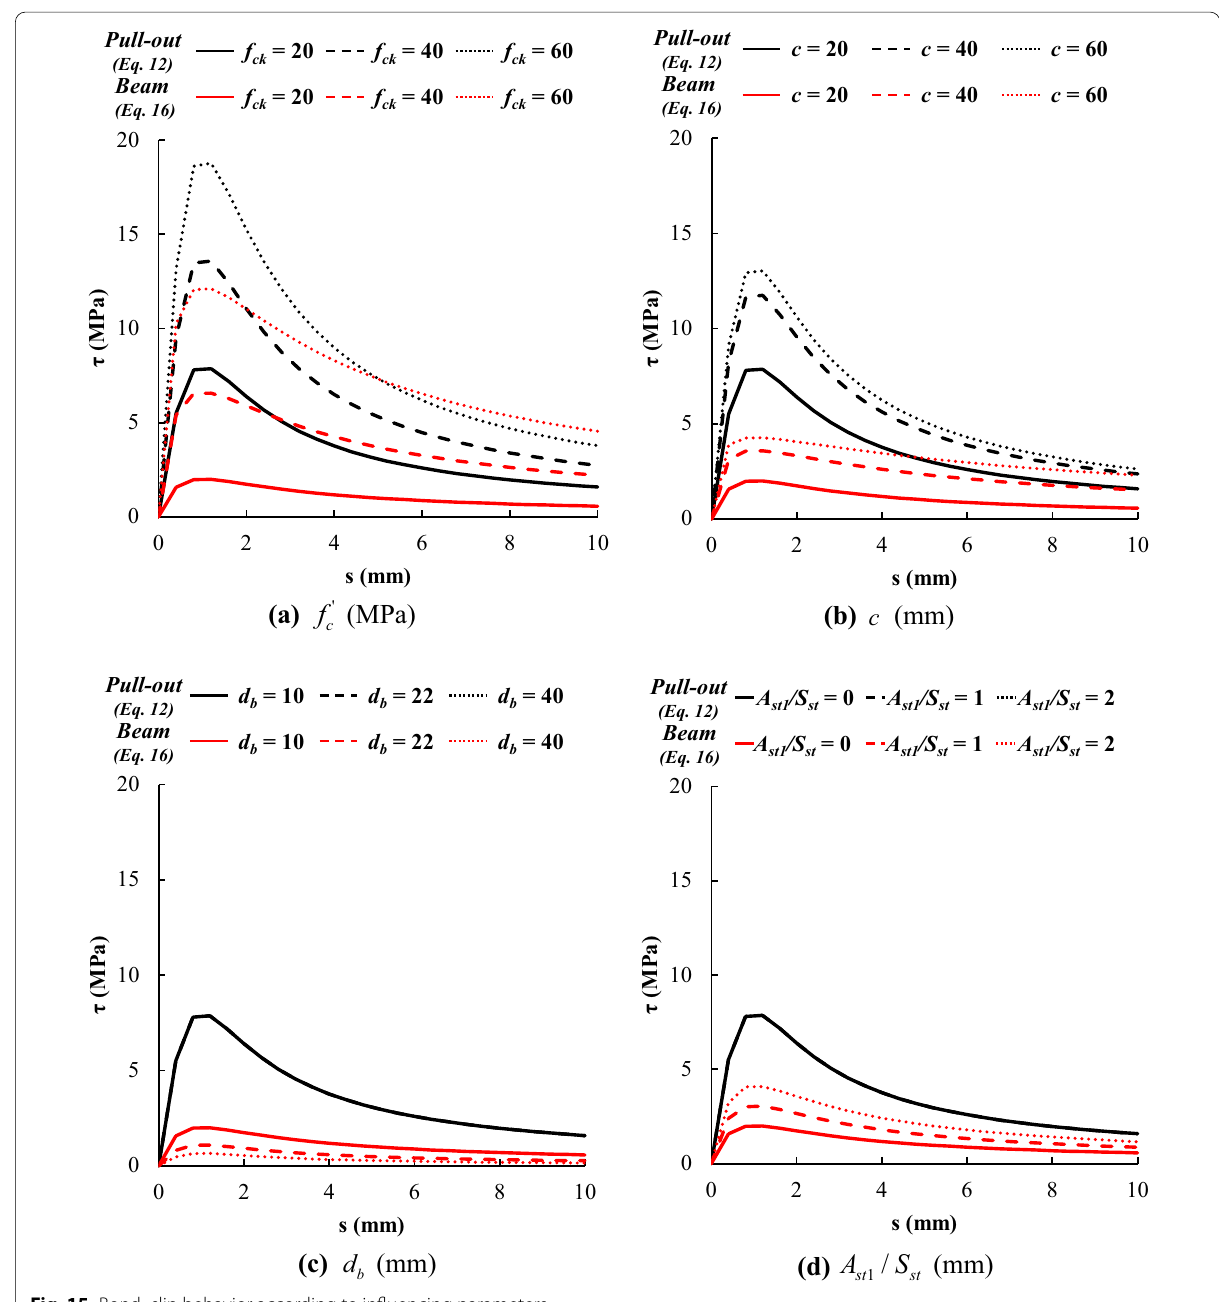
Fig. 15 Bond–slip behavior according to influencing